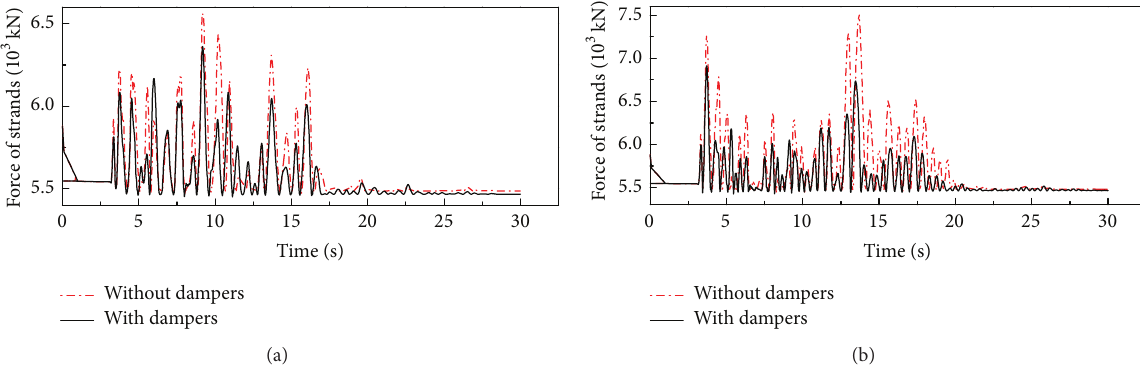
Figure 12: Tension force of the tendons: (a) longitudinal direction; (b) transverse direction.